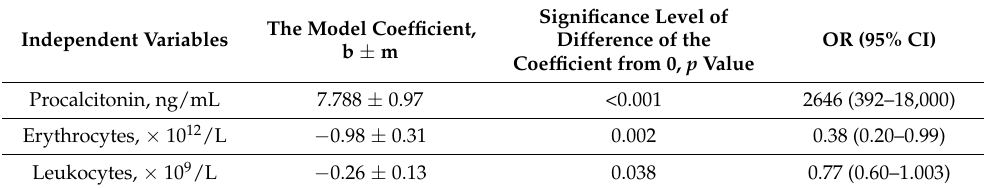
Table 2. Analysis of risk of death in a three-factor logistic regression model.